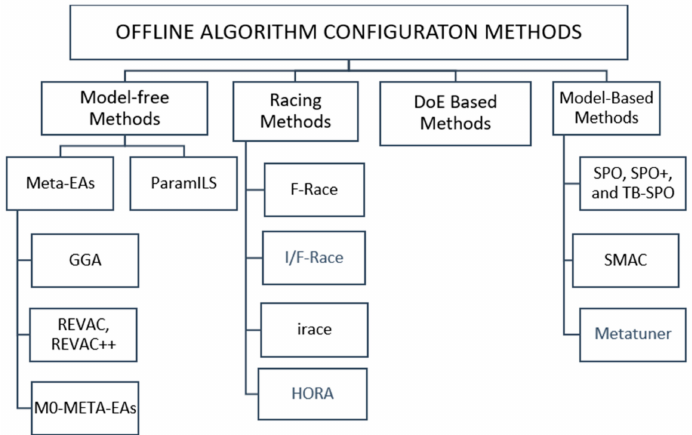
Figure 1. An illustration of the classification of automated algorithm configuration